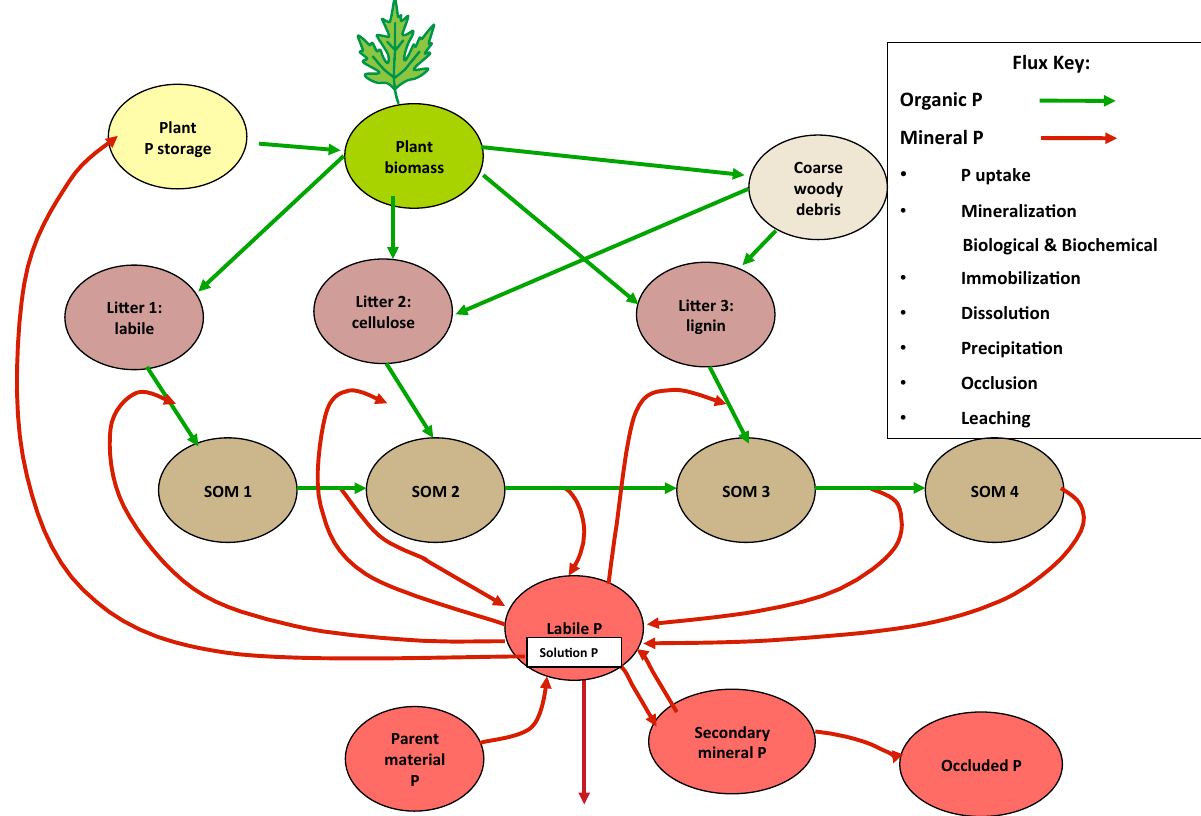
Fig. 1: Pools and fluxes of P component in CLM-­‐CN (Solution P is assumed to be in Fig. 1. Pools and fluxes of P components in CLM-CN (solution P is assumed to be in equilibrium with the labile P equilibrium with labile P pool).